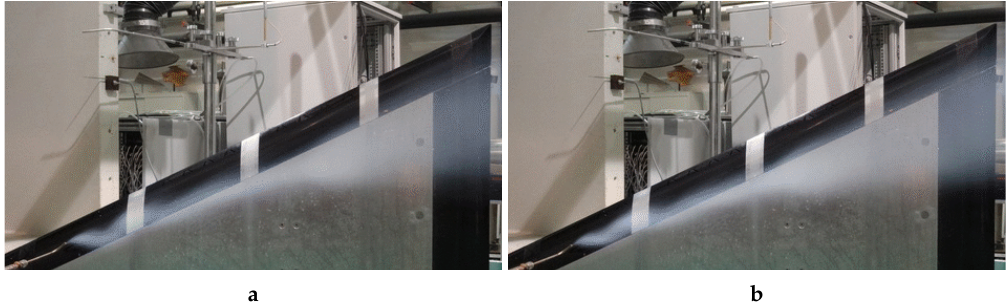
Figure 4. Smoke visualization of the core flow α = 23 ◦ showing different breakdown positions corresponding to consecutive instances: ( a ) t 1 and ( b ) t 1 + ∆ t